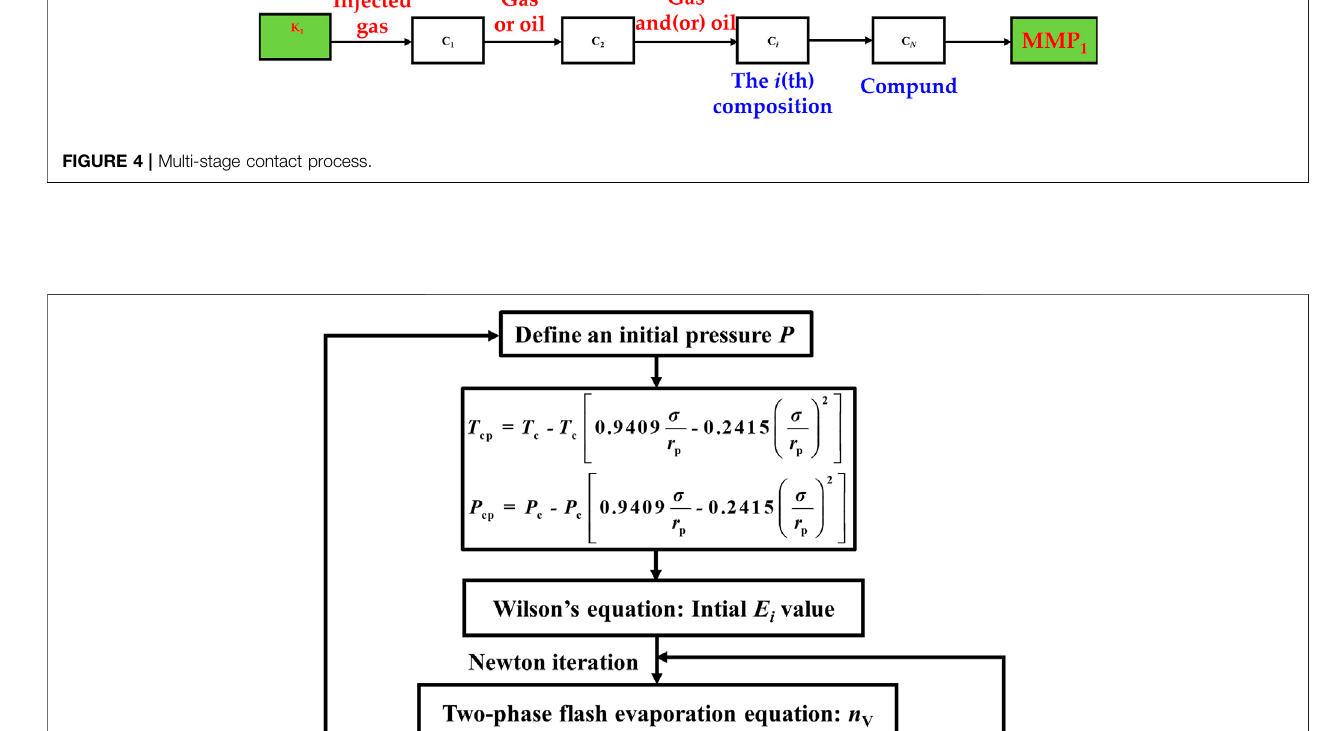
Frontiers in Energy Research |